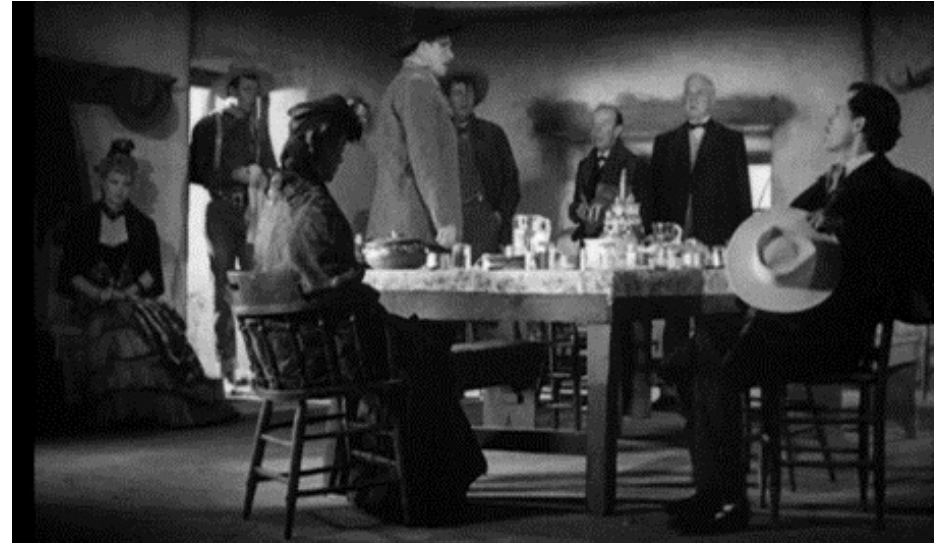
Figure 3: Dallas sits in shadow by the door with Ringo. Mrs. Mallory and Hatfield sit at the head of the table. The group discusses going on without military escort. The Marshal elicits the votes of the members beginning with Mrs. Mallory. When he skips Dallas – not worthy of consulting – Ringo corrects his